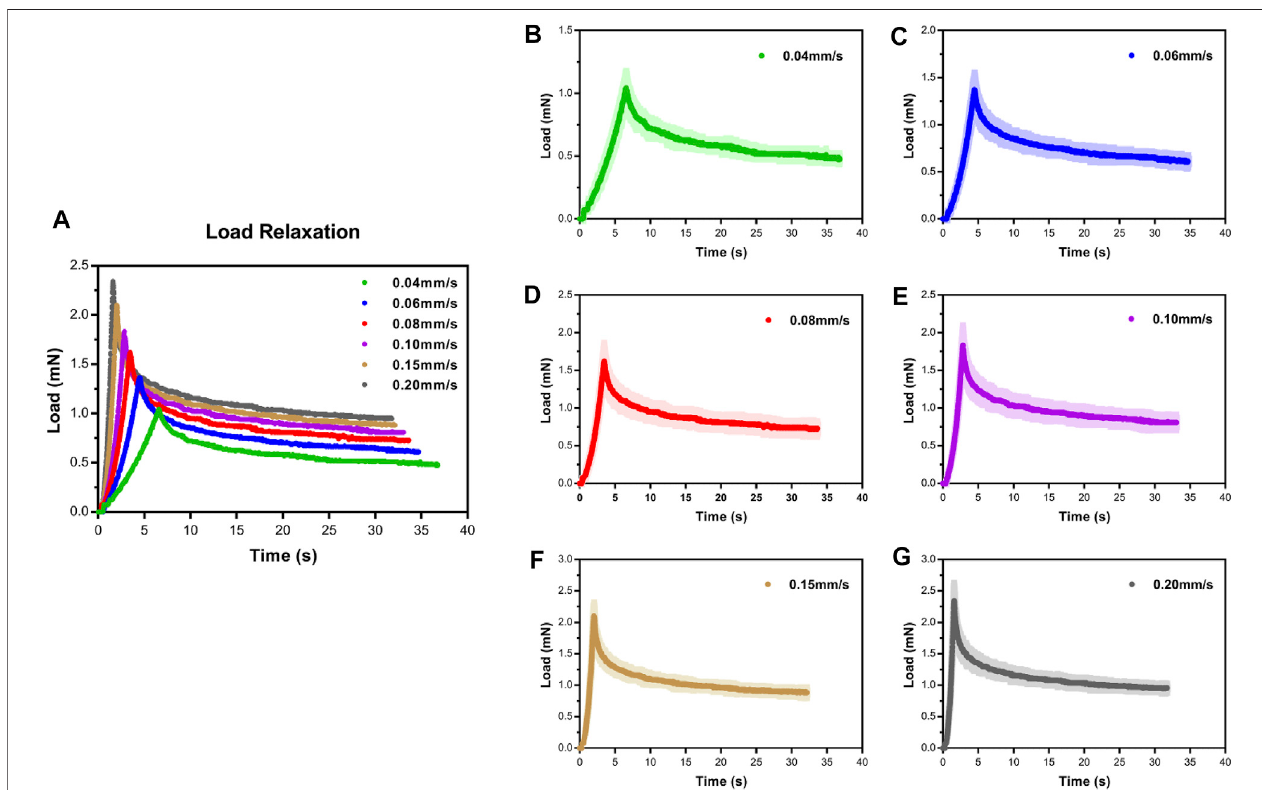
FIGURE3| Load – timecurvesshowedloadingandrelaxationforSCPCtissueupto0.25-mmdisplacementatvaryingvelocitiesusing0.50-mmradiusindenter (A) . Mean ± standard deviation load – time curves for SCPC indentation experiments (B – G) .